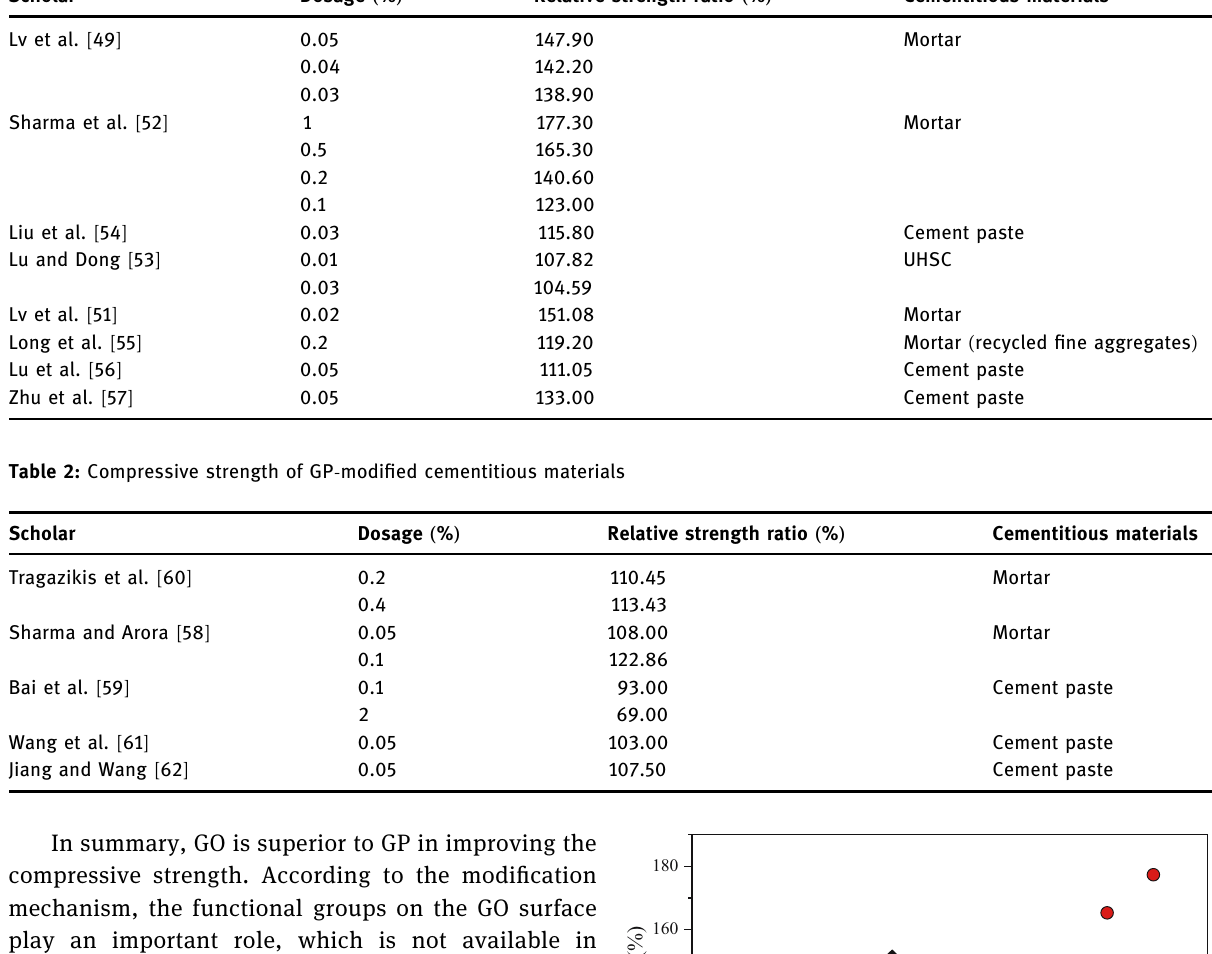
Table 1: Compressive strength of GO - modi fi ed cementitious materials Scholar